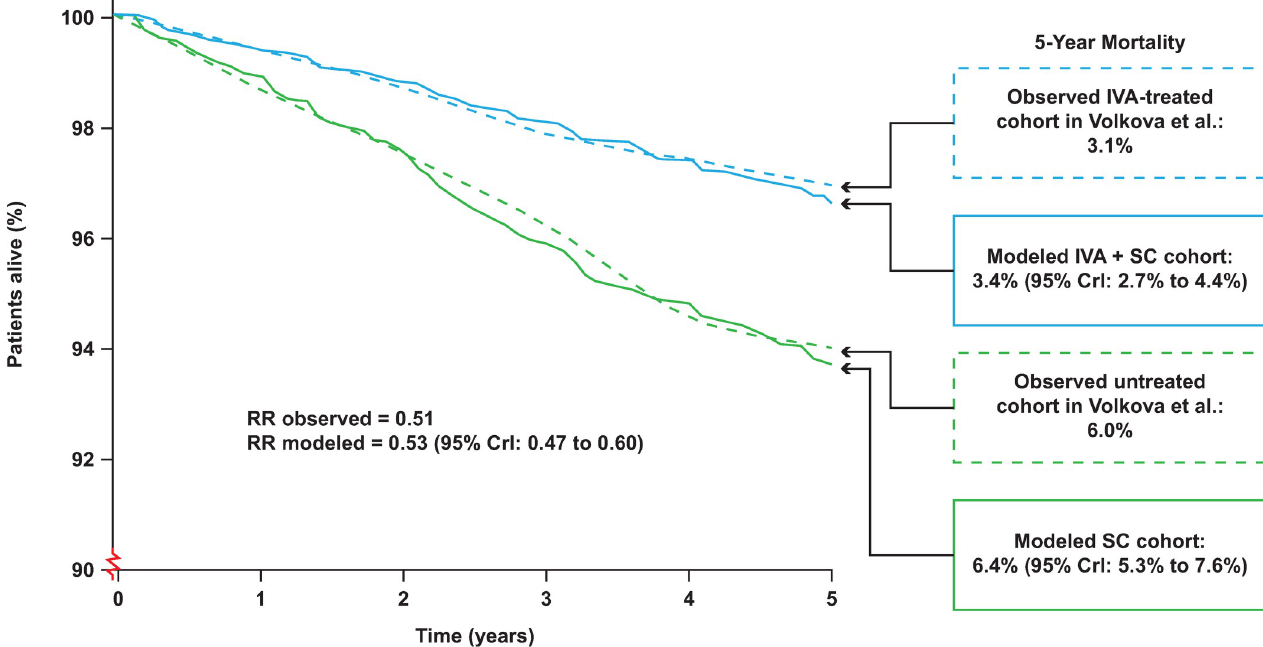
Fig 2. Comparison of observed and modeled 5-year mortality benefits of ivacaftor. CrI, credible interval; IVA, ivacaftor; RR, relative risk; SC, standard care.